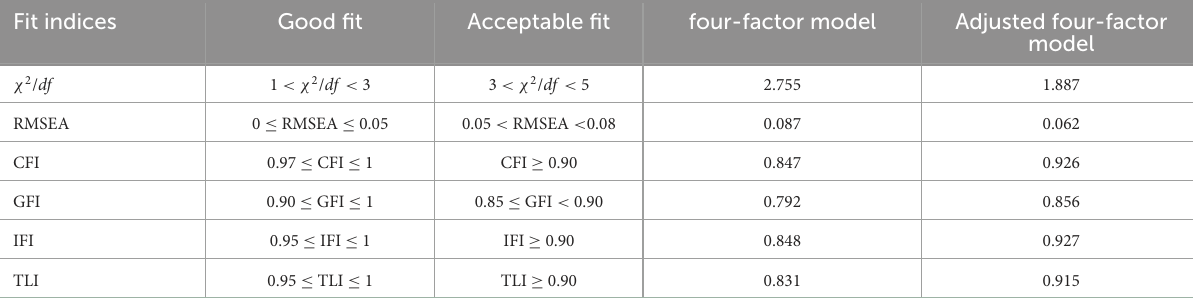
TABLE 3 Fit indices of the models ( N = 234).